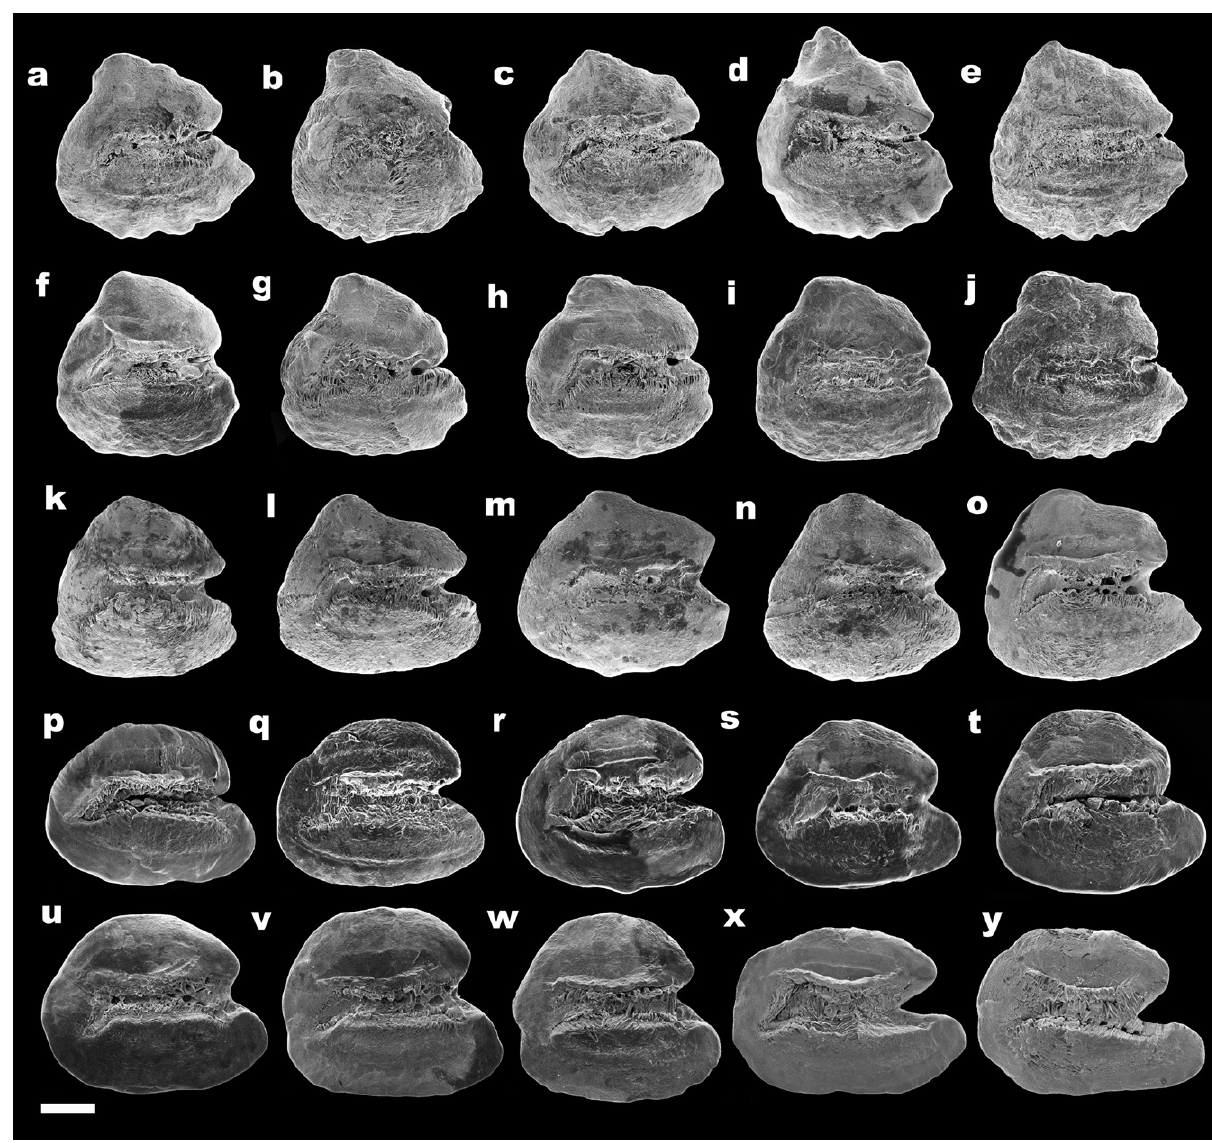
Fig . 3. – Otoliths of Aphanius dispar from the studied sites. a-e, site 1 near Sib, Oman; f-j, site 2 near Sib, Oman; k-o, Khor Hulaylah, United Arab Emirates; p-t, Hormuzgan Basin, Iran; u-y, Helleh Basin, Iran. Note presence and absence of a dorsal tip, distinctive shapes and different proportions of rostrum and antirostrum. All images are SEM micrographs, showing left otoliths in medial view. Scale bar 200